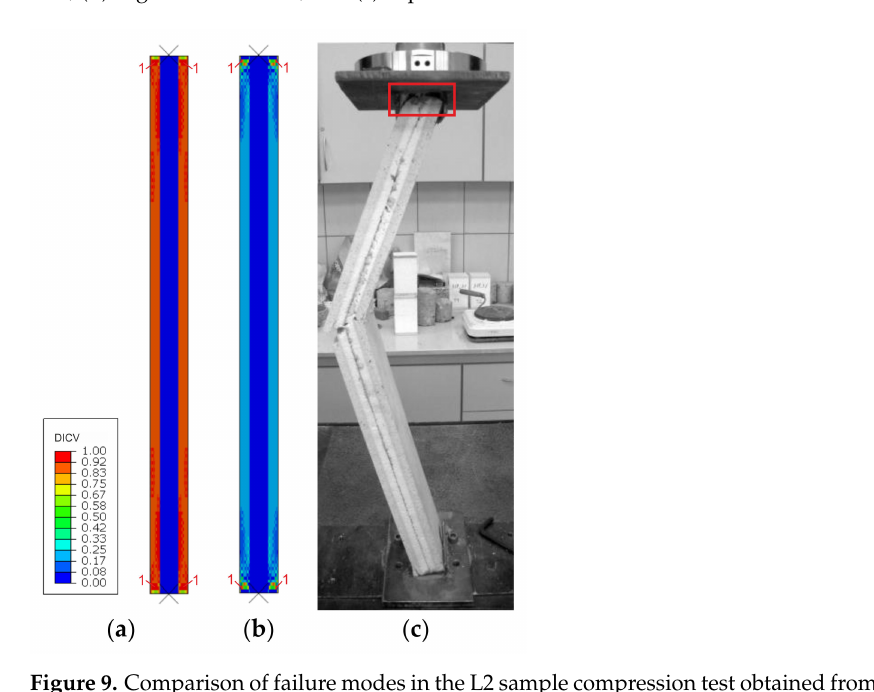
Figure 8. Comparison of failure modes in the L1 sample compression test obtained from FEA ( a ) MgO min, ( b ) MgO max variants, and ( c ) experimental observation.